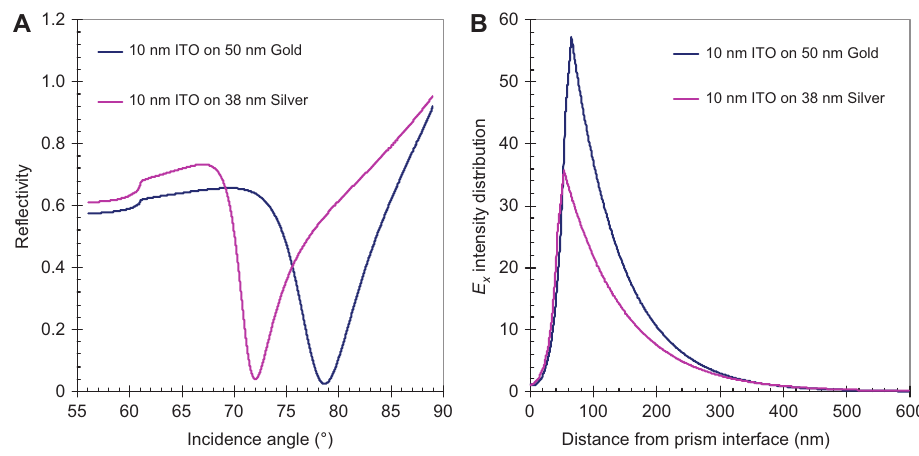
Figure 10 SPR (A) and EM fi elds calculations (B) for gold and silver based SPR interfaces with a 10 nm ITO overlayer; parameters used for = 1.52, λ = 670 nm, n = 1.33, n = 1.91 + i0.2491, n = 2.32 + 3.08i, d = 5 nm. calculations: n prism analyte SnO 2 /Sb Ti Ti